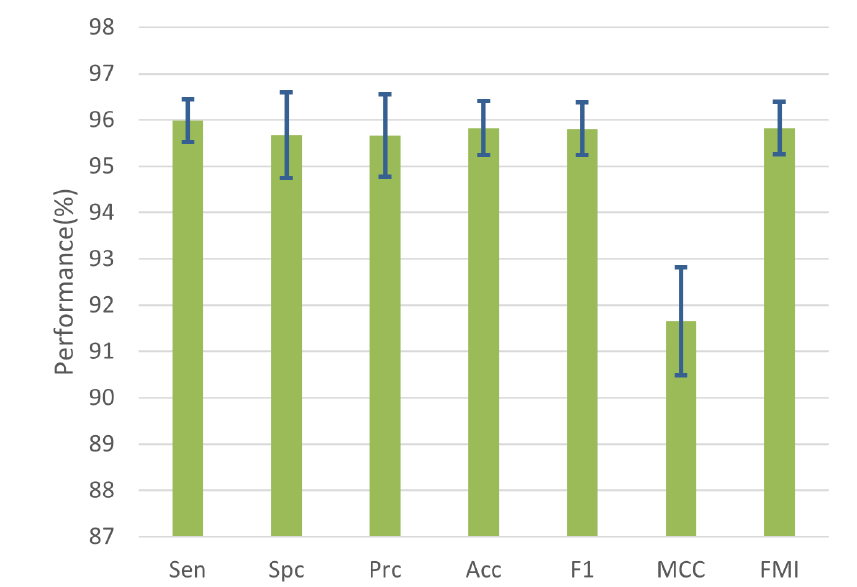
Figure 6. Error bar of stochastic pooling